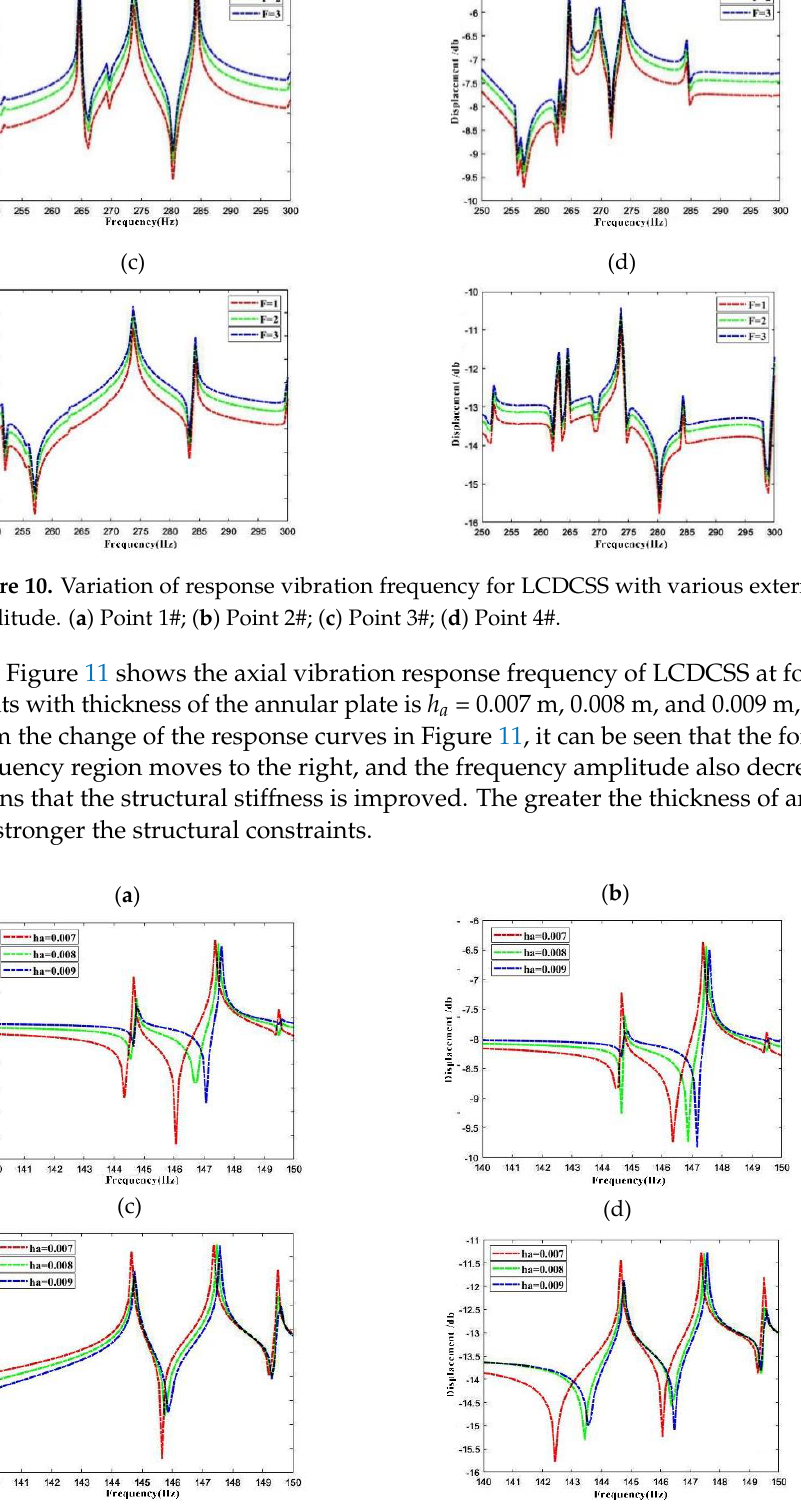
Figure 11. Variation of axial dynamic response vibration frequency for LCDCSS with various thick- nesses of annular plates. ( a ) Point 1#; ( b ) Point 2#; ( c ) Point 3#; ( d ) Point 4#.